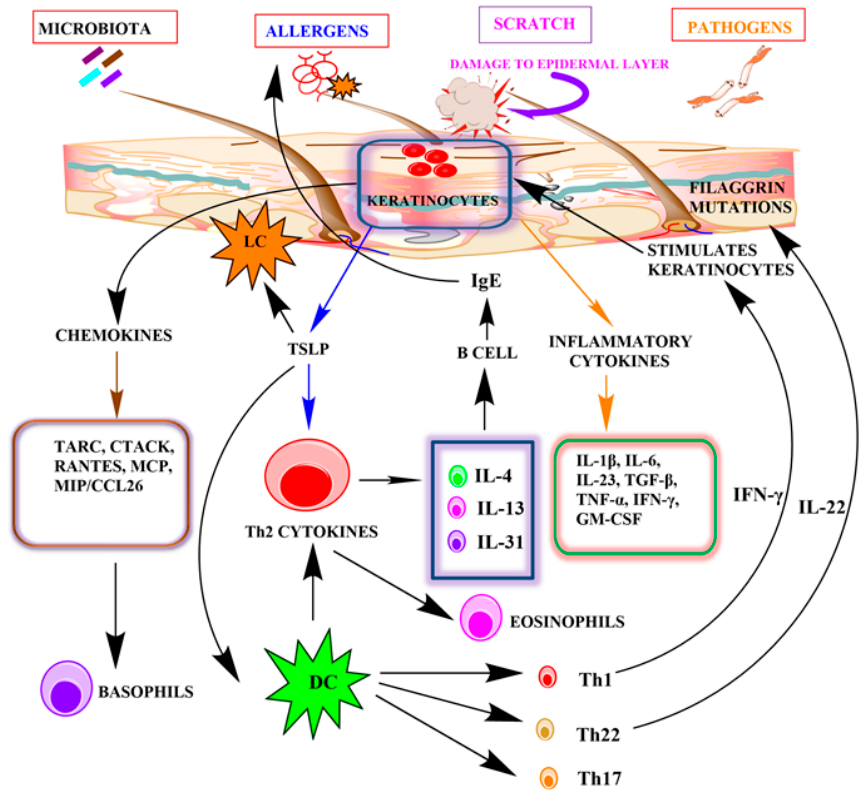
Figure 2. The role of keratinocytes in the pathogenesis of atopic dermatitis. Bacterial and viral infections are also frequent complications found to be associated with AD. The defective skin barrier along with the inability of keratinocytes to combat secondary skin infections are the major reasons behind these complications. There are abnormal bacterial colony formations, especially of Staphylococcus aureus, in the cases of more severe AD patients, and Staphylococcus epidermidis colonization is found